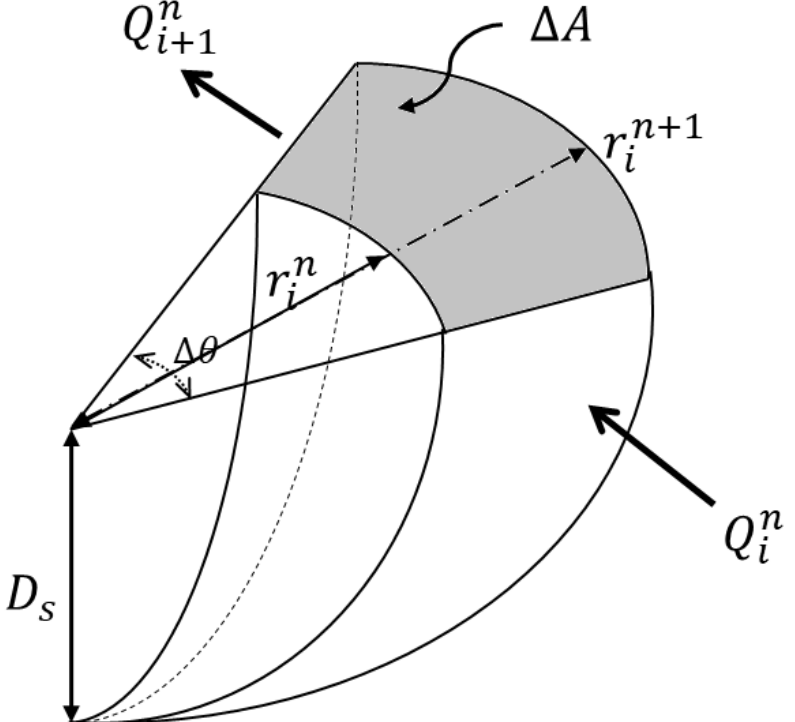
Figure 2. The control volume between two consecutive time steps.